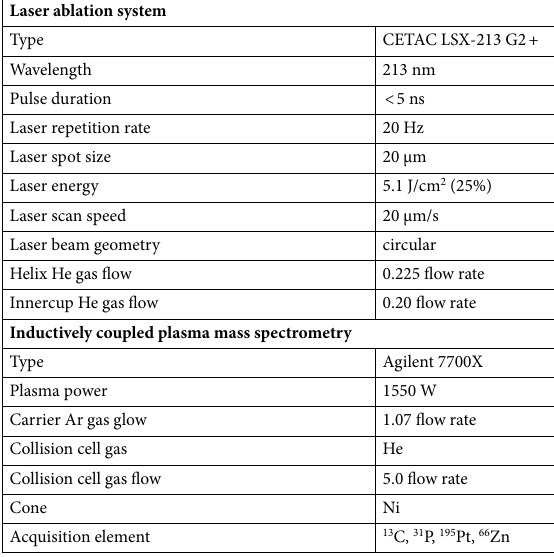
Table 1. LA-ICP-MS operational conditions. C carbon, He Helium, LA-ICP-MS laser ablation inductively coupled plasma mass spectrometry, Ni nickel, P phosphorus, Pt platinum, Zn zinc.